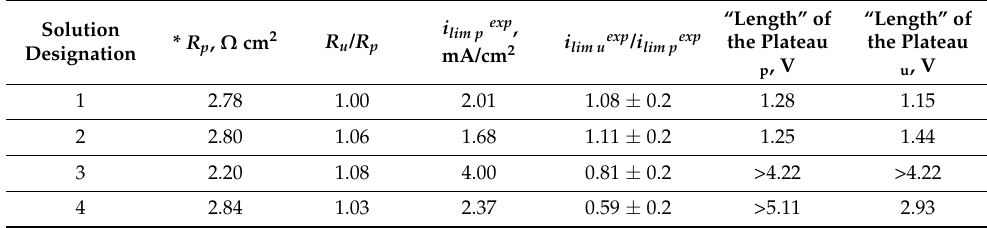
Figure 11. Current–voltage curves of the CJMA-6 membrane before (indicated as pristine) and after (indicated as used) ED processing of model solutions 1 ( a ), 2 ( b ), 3 ( c ) and 4 ( d ). The numbering of the solutions corresponds to Table 2. Table 4. Some parameters of the current–voltage curves of the CJMA-6 anion-exchange membrane obtained in model solutions before (index p) and after (index u) electrodialysis.